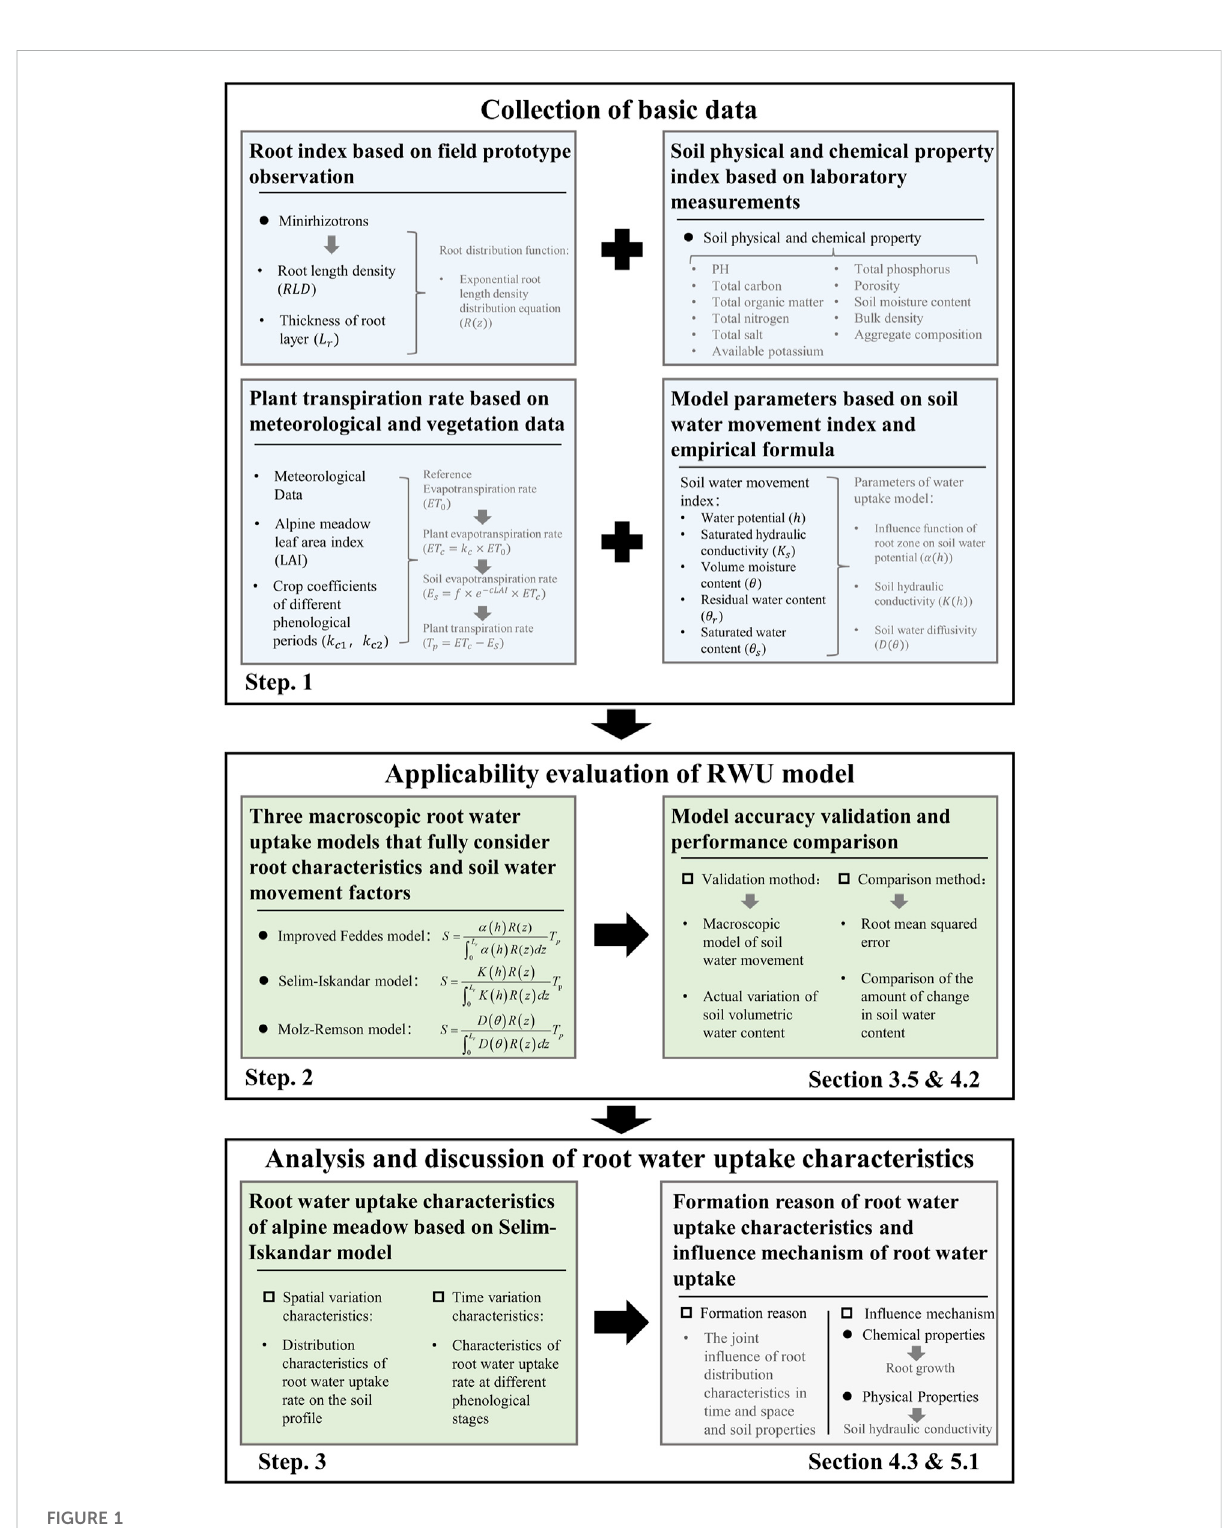
FIGURE 1 Research fl ow